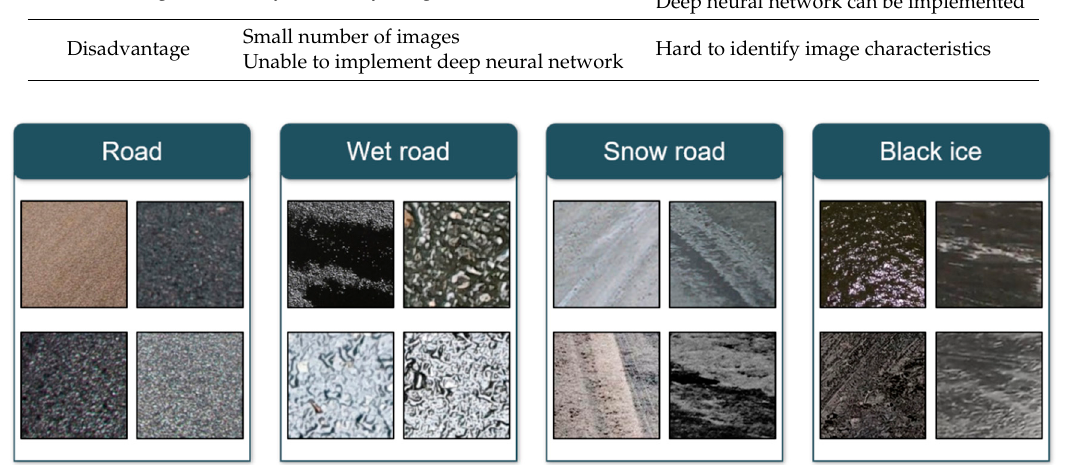
Figure 2. The results of the data split.